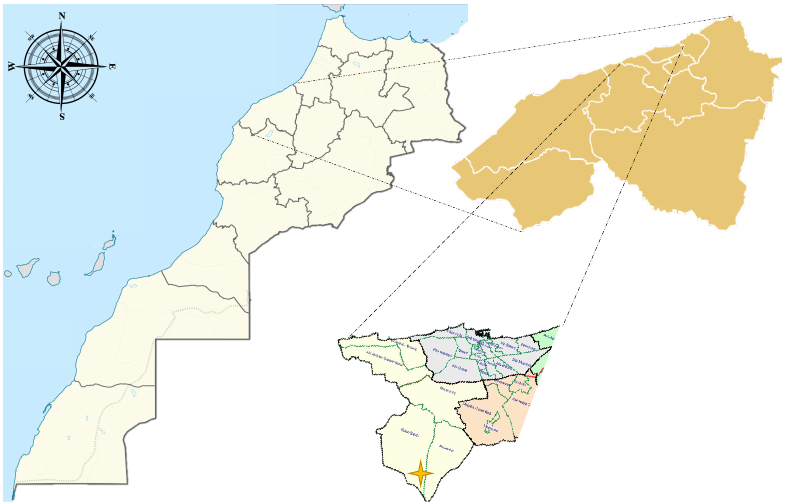
Figure 7. Geographic location of the study area (Casablanca,